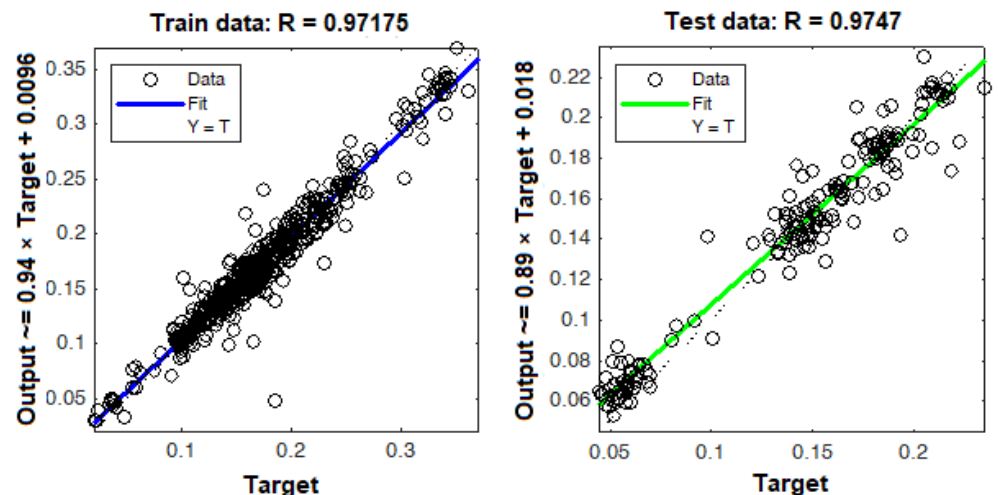
Figure 13. Regression coefficients for the training and testing phase for modelling with ANFIS subtractive clustering method.